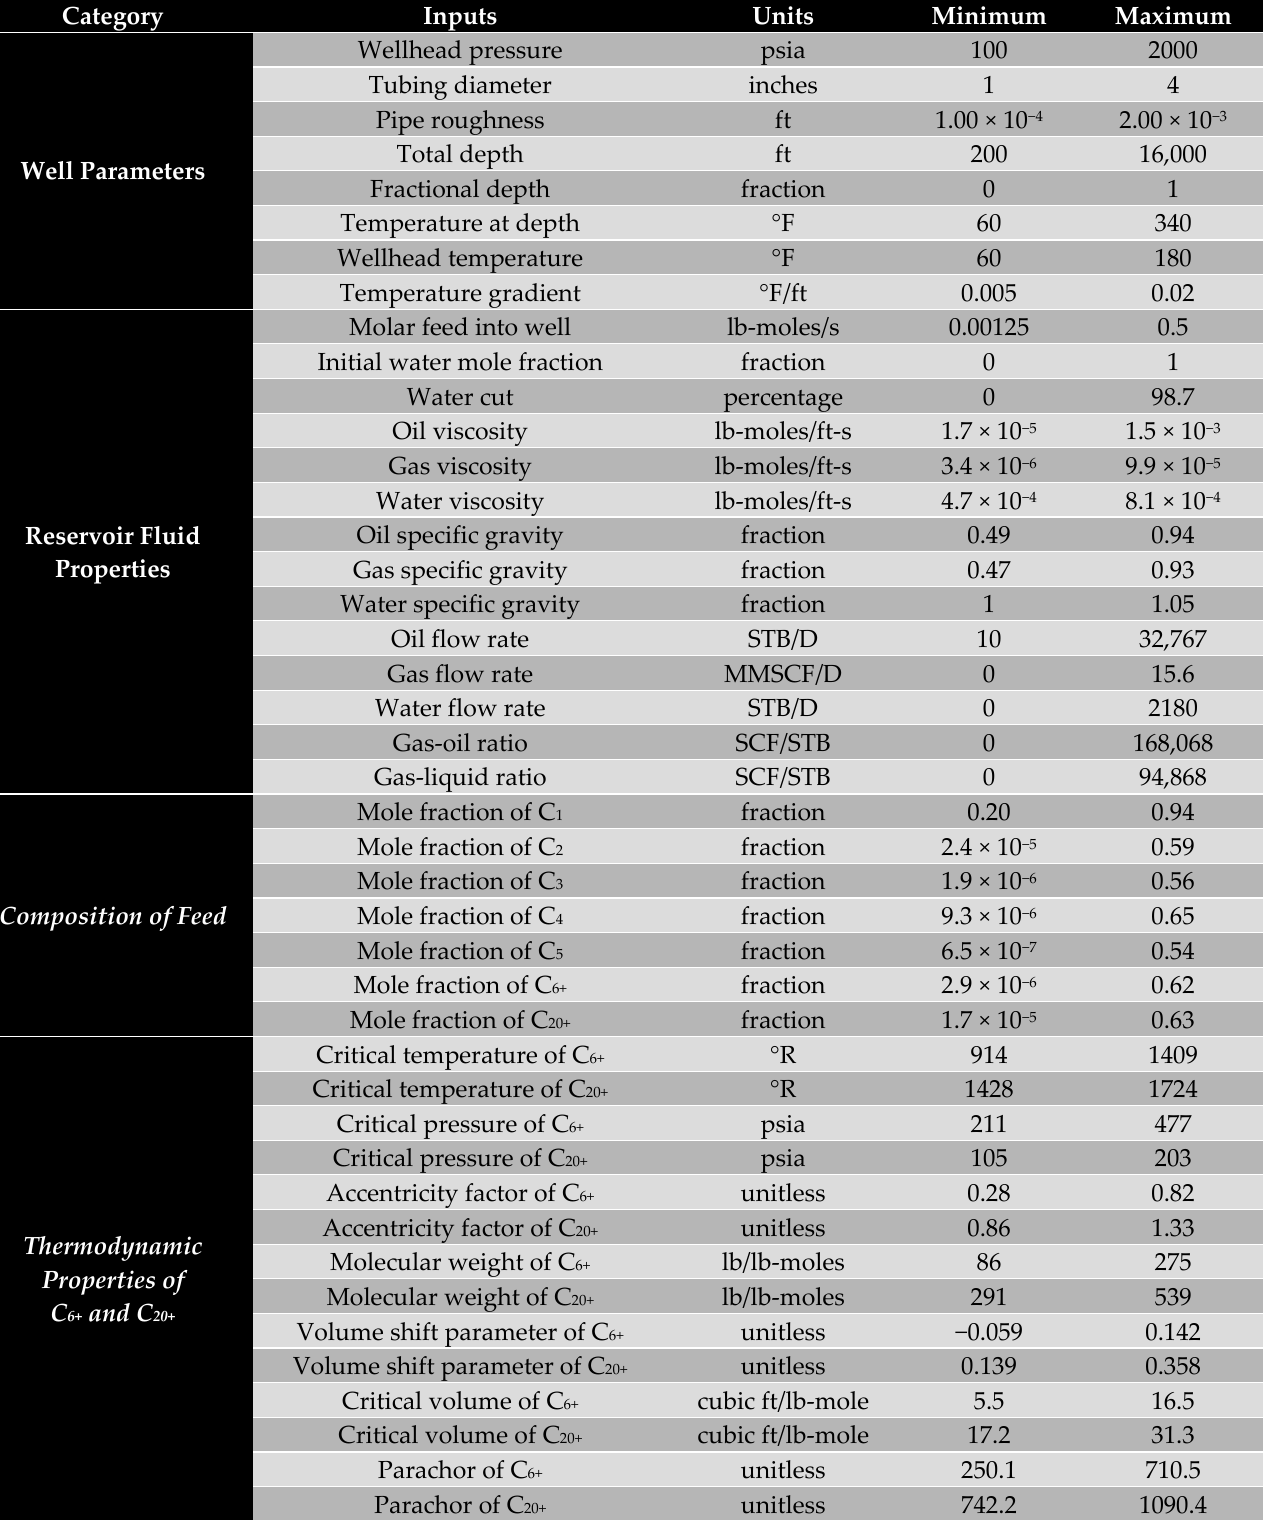
Table 4. Input parameters used in the construction of the ANN-based wellbore model.